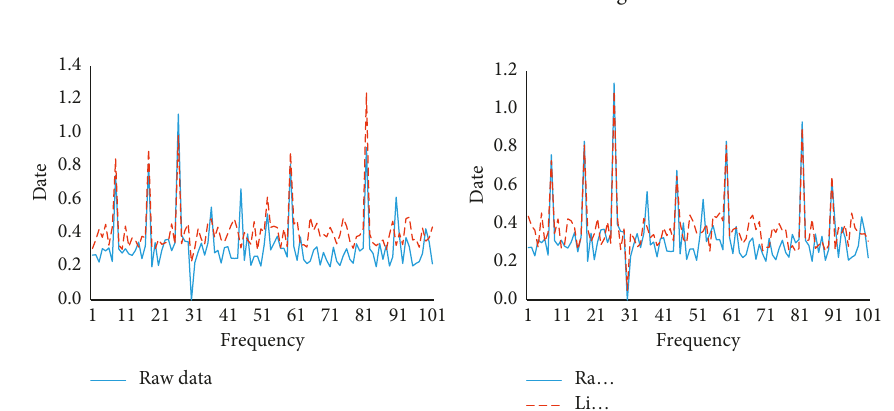
Figure 7: Comparison of parameters of different methods.